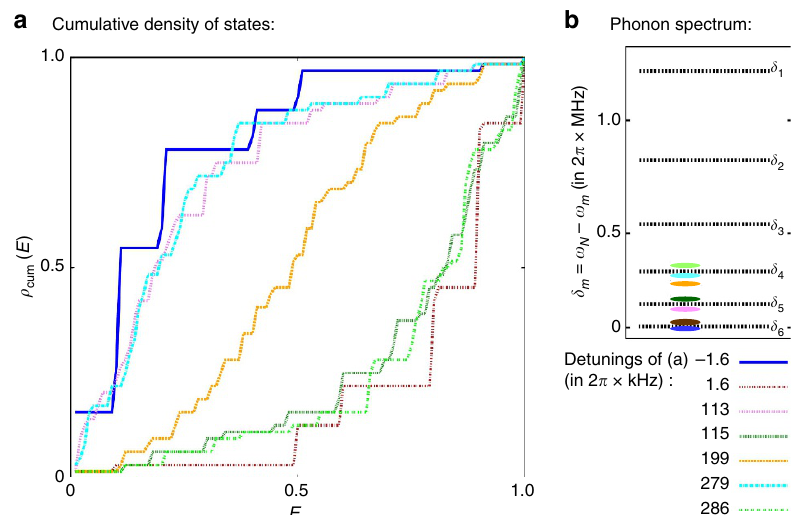
Figure 2 | Cumulative density of states. ( a ) For six ions and at trap frequency o z ¼ 2 p (cid:2) 770kHz, we plot the number of states (divided by the total Hilbert space dimension) below the normalized energy treshold (0: ground state energy, 1: energy of highest state), for different detunings from the centre- of-mass mode, d ¼ o N (cid:3) o L . The density of states at low energies is seen to strongly increase when the detuning is slightly above a phonon resonance. In b the position of the resonances (measured from the centre-of-mass mode at d N ¼ 0) are